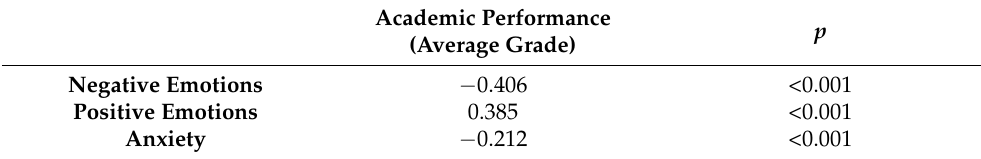
Table 7. Pearson Test